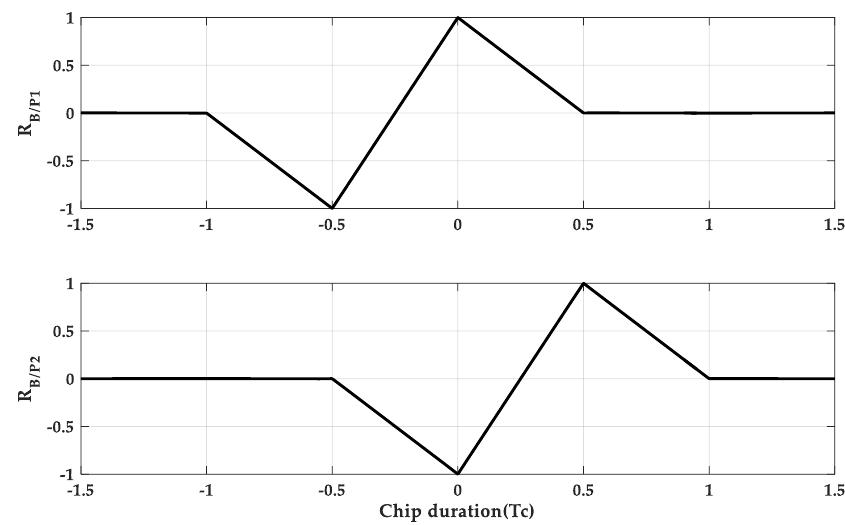
Figure 7. The normalized sub cross-correlation functions at M = 2.